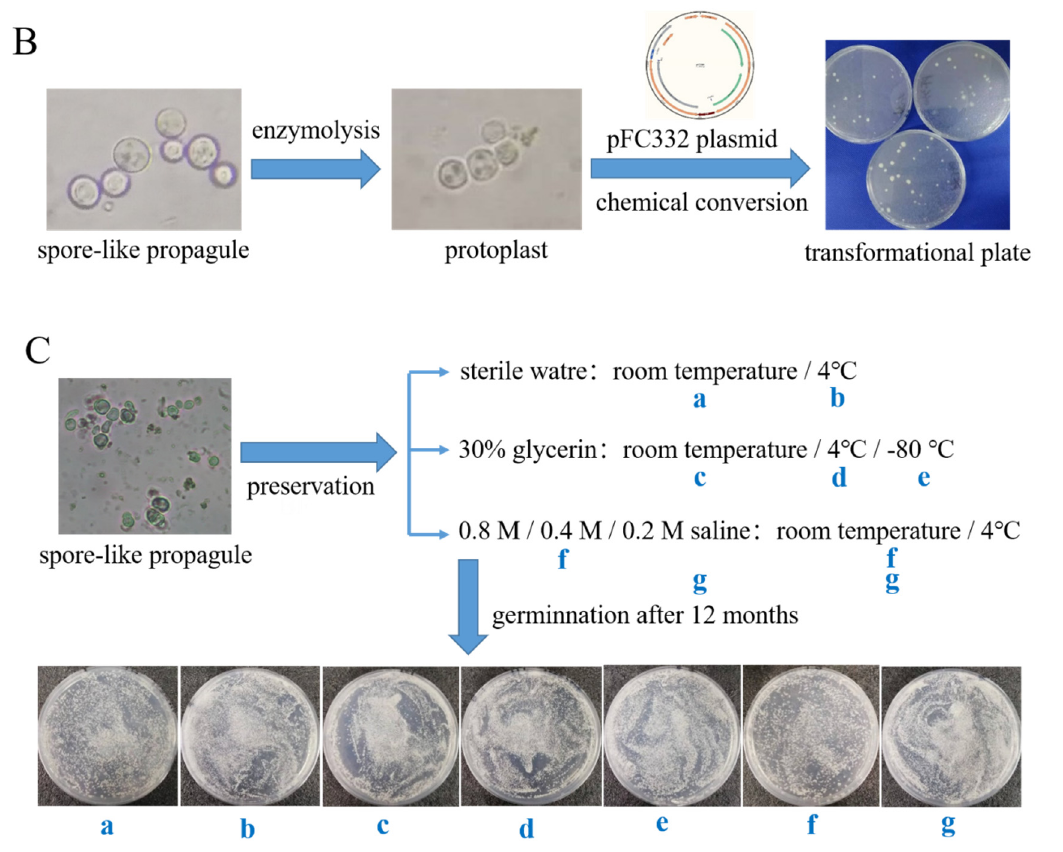
Figure 2. The life activity assay of the spore-like propagule. ( A ) The morphological phenotype of the spore-like propagules and normal hyphae on CD plates and NCD plates contained 300 µ g/mL calcofluor white, 600 µ g/mL cargo red, and 3 µ M camptothecin. SLP means that the spore-like propagules were inoculated onto CD plates and NCD plates, and hypha means that the normal hyphae were inoculated onto CD plates and NCD plates. ( B ) The enzymolysis of spore-like propagules and chemical conversion of the protoplasts of the spore-like propagules for genetic transformation assay. The pFC330 plasmid was transferred into A. niger SH2 ∆ ku ∆ pyrG . ( C ) The different preservation conditions of spore-like propagules and the recovery of spore-like propagules. The pure spore-like propagules were preserved in sterile water, 30% glycerin, and 0.8 M/0.4 M/0.2 M saline under room temperature, 4 °C and − 80 °C, respectively. After 12 months, the preserved spore-like propagules were recovered under CD plates. The blue letters were the related preservation conditions and the corresponding plates.